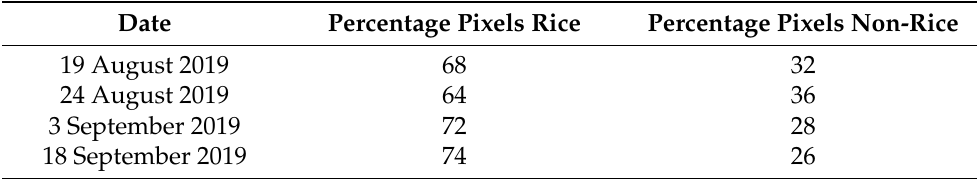
Table 13. Percentage pixel distribution of the zonal statistics for weak